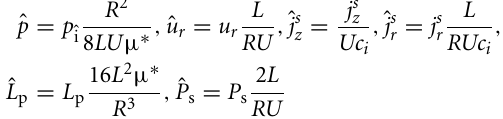
values ˆ p i , ˆ p out